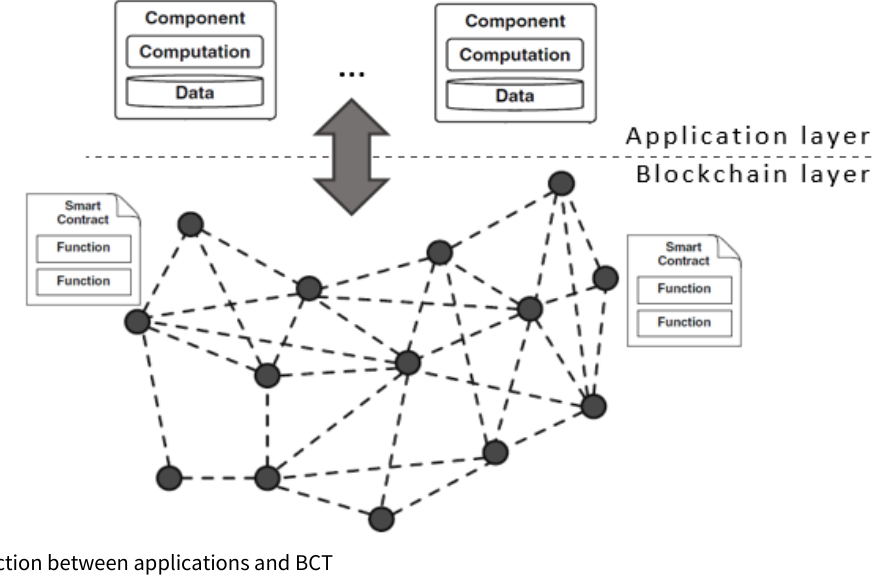
Figure 2. Interaction between applications and BCT